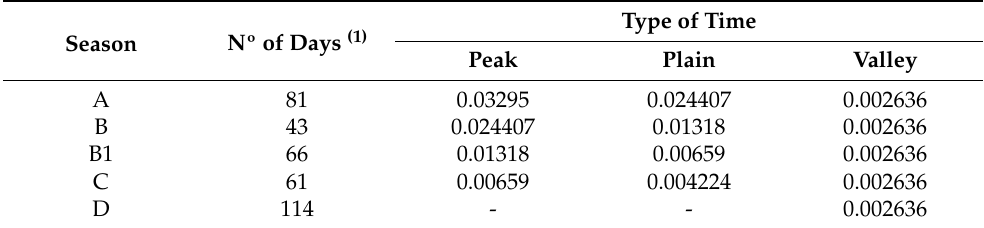
Table 11. Price of energy, in euros per kWh, as a function of the type of time and the season. (1) Number of days between September 2020 and August 2021. Type of Time Season Nº of Days (1) Peak Plain Valley